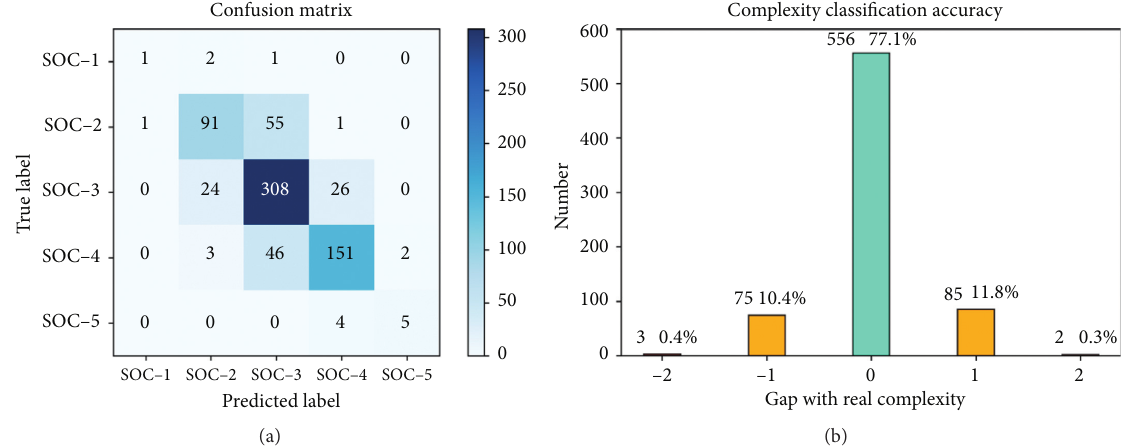
Figure 8: Situation between the predicted SOC and real SOC: (a) confusion matrix of prediction; (b) SOC evaluation error distribution.